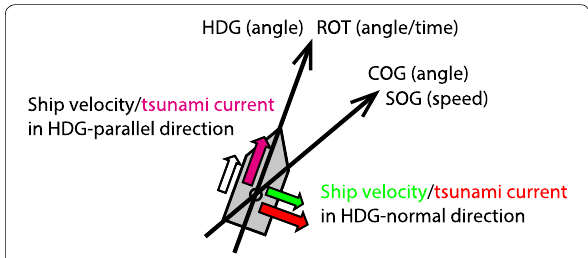
Fig. 2 Schematic of speed over ground (SOG), course over ground (COG), ship heading (HDG), and rate of turn (ROT). HDG-normal and HDG-parallel components of the ship velocity are v n = SOG sin(COG − HDG) and v p = SOG cos(COG − HDG) , respectively. Tsunami currents in both the components are